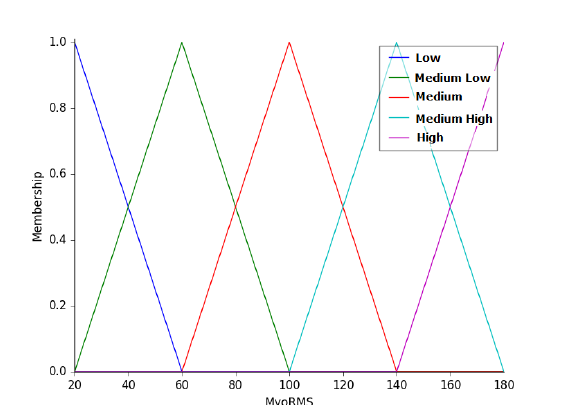
Figure 6. Membership functions of the variable